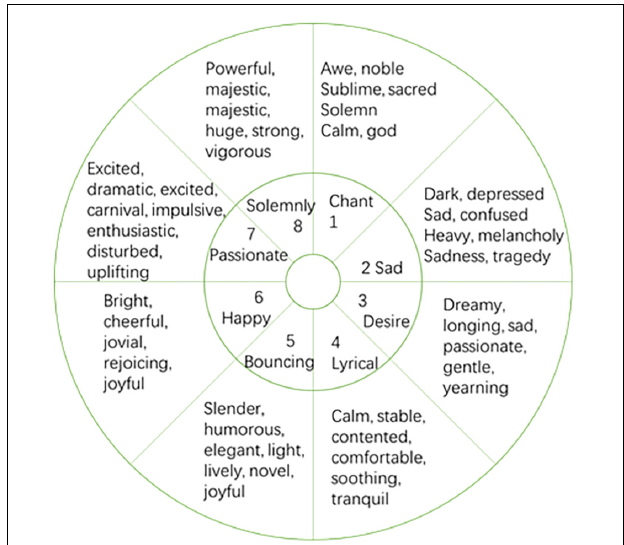
FIGURE 2 | Hevner emotional model.